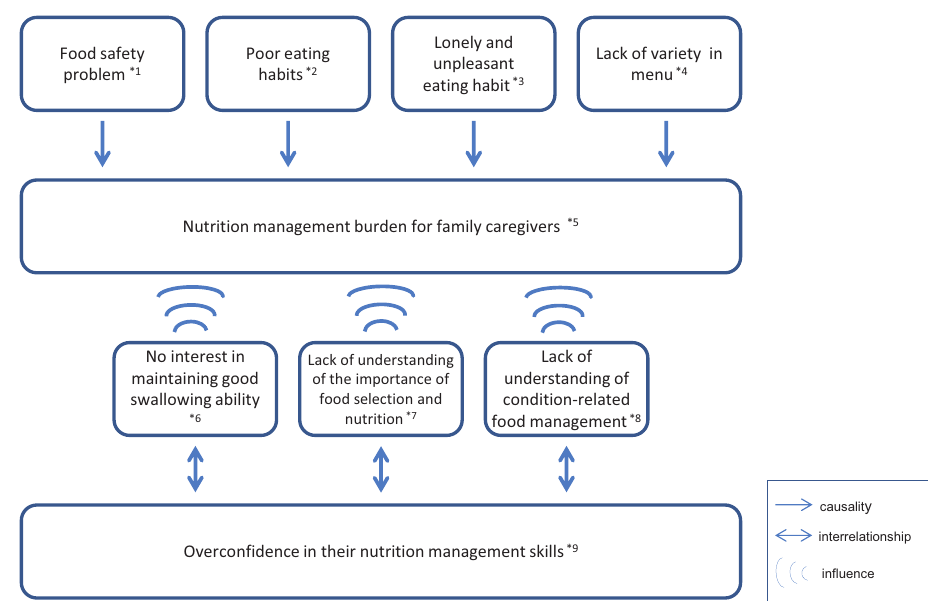
Figure 3. Current situation and challenges of home nutrition service for Japanese frail older adults: A wide range of nutrition management issues among older adults increases caregivers’